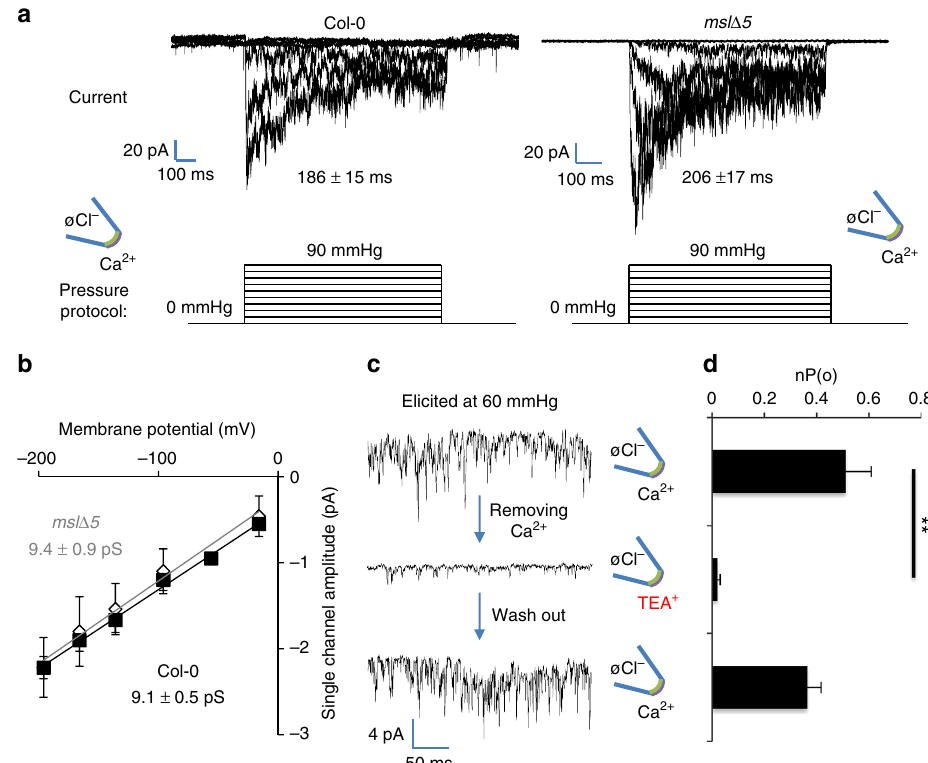
Fig. 1 A mechanically activated current permeable to Ca 2+ is present at the plasma membrane. a Representative membrane patches from Col-0 ( left ) and an msl quintuple mutant msl4 ; msl5 ; msl6 ; msl9 ; msl10 ( msl Δ 5 , right ), exposed to increased positive pressure steps in an outside-out patch con fi guration show a rapidly activated, rapidly inactivated current in ionic conditions favorable for Ca 2+ current recording. We have named the channel responsible for this activity the RMA channel (see text). Time constants are means ± SE ( n = 6); b Under the same conditions, single channel I/V curves show similar RMA channel conductance in Col-0 ( solid square ) and in the msl Δ 5 mutant ( open square ). Values are means ± SE ( n = 6); c Representative single